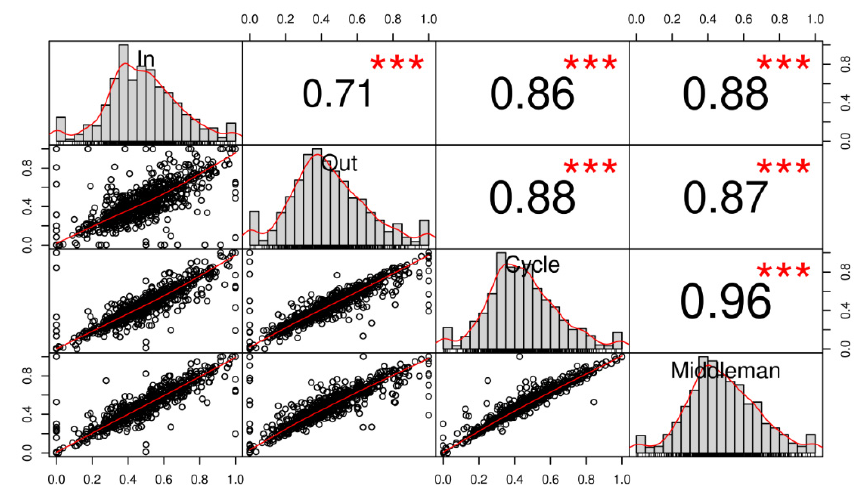
Figure 5. Correlation matrix of clustering coefficients.